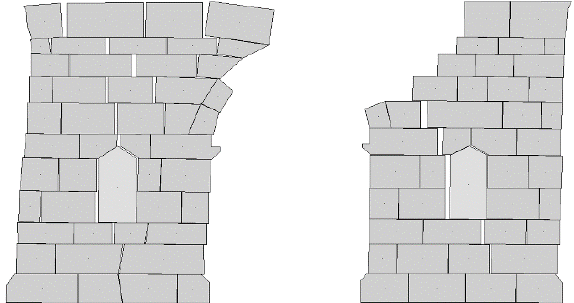
Figure 14. Structure damaged during the 2nd phase.